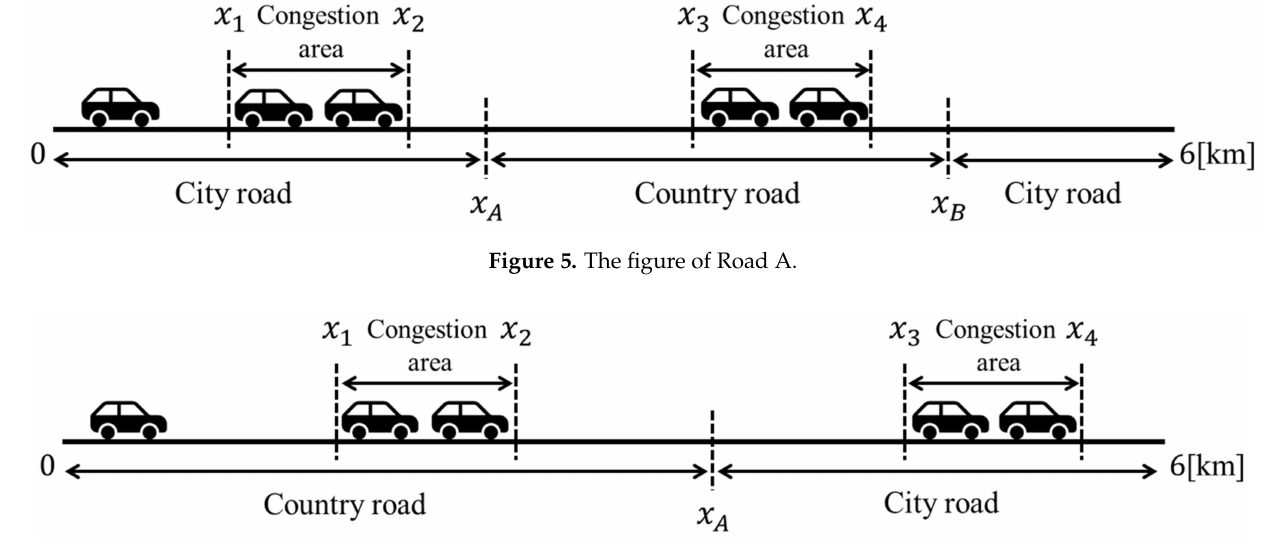
Figure 6. The figure of Road